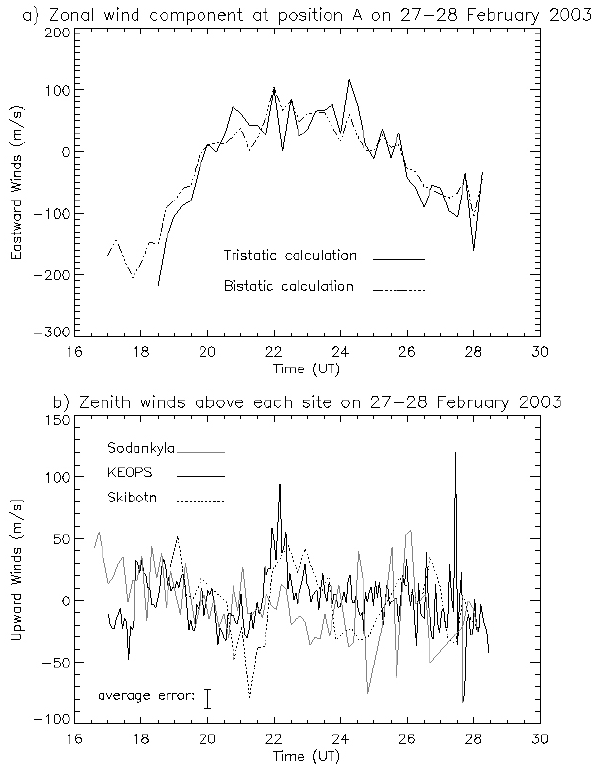
Fig. 2. (a) Comparison of zonal wind component calculated using tristatic (all 3 FPIs) and bistatic (only KEOPS + Sodankyl¨a) line- of-sight measurements on the night of 27–28 February 2003. (b) Comparison of the vertical wind component observed by each of the 3 FPIs on the night of 27–28 February